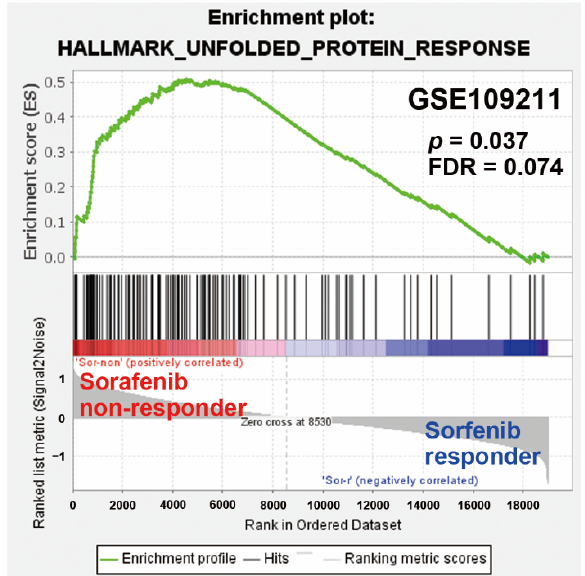
Figure 6. GSEA for UPR genes in HCC patients receiving sorafenib therapy. The microarray dataset (GSE109211) of sorafenib responsive and non-responsive HCC patients were analyzed by GSEA for the enrichment of the UPR cancer hallmark.